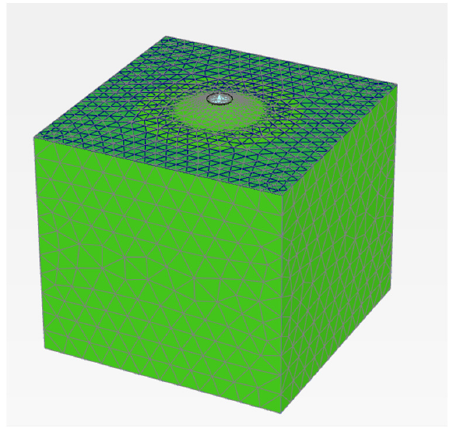
Figure 10. Deformed mesh.